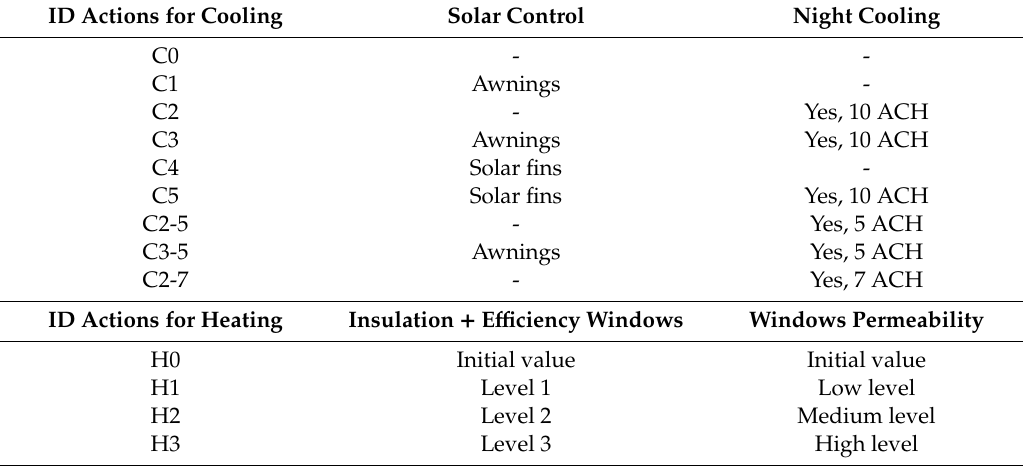
Table 6. Definition of alternatives for reducing energy